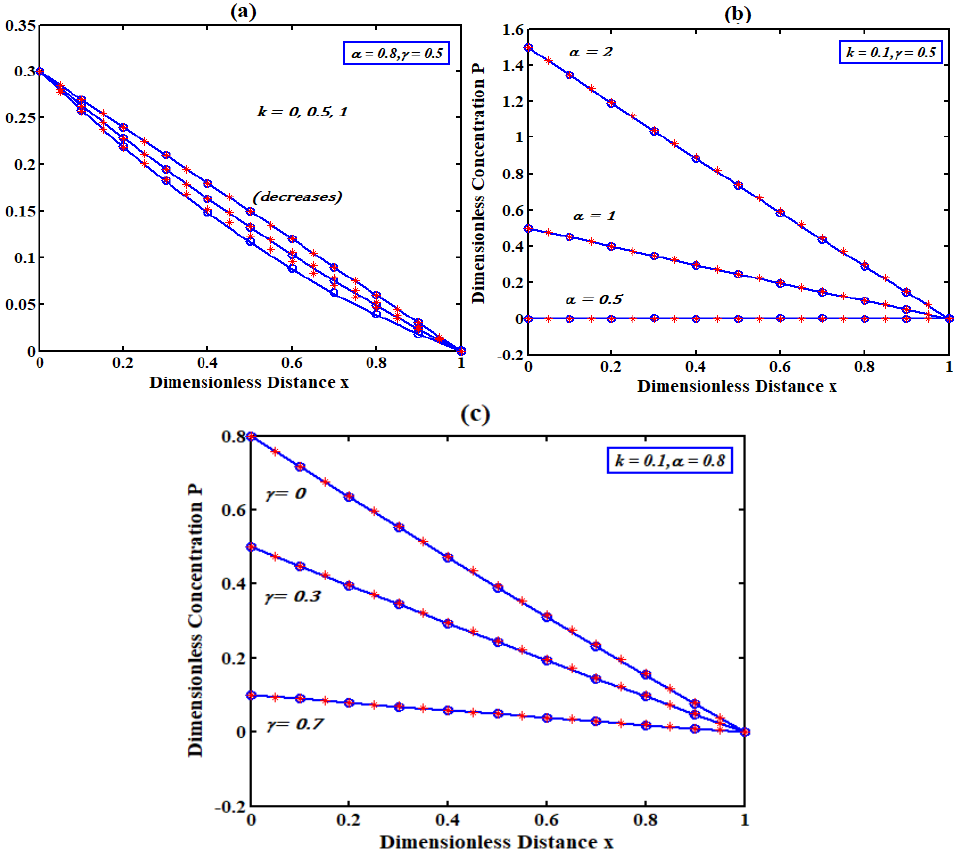
Figure 3. ( a – c ): Profile of the normalized steady-state concentrations P versus the normalized distance x for various values of the parameters α , k , and γ using Equations (11) and (16). The solid line denotes the AGM method, (o o o) represents DTM, and (* * *) denotes numerical simulation.